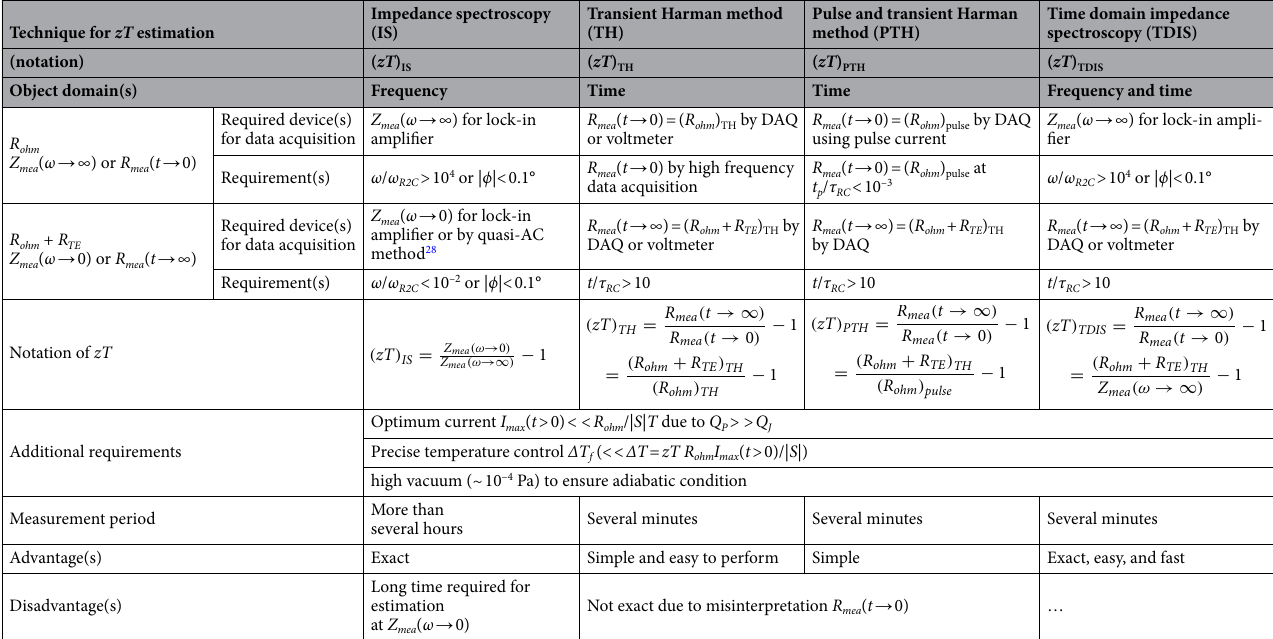
Table 1. A summary of techniques for direct zT estimation and its